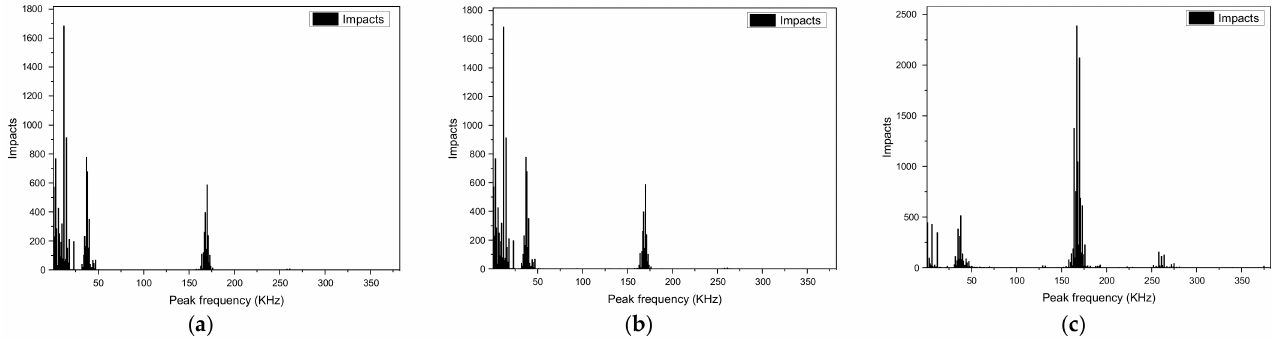
Figure 8. The distribution of impacts in terms of the peak frequency of A-7-80% samples for three stages. ( a ) Initial stage. ( b ) Stable stage. ( c ) Active